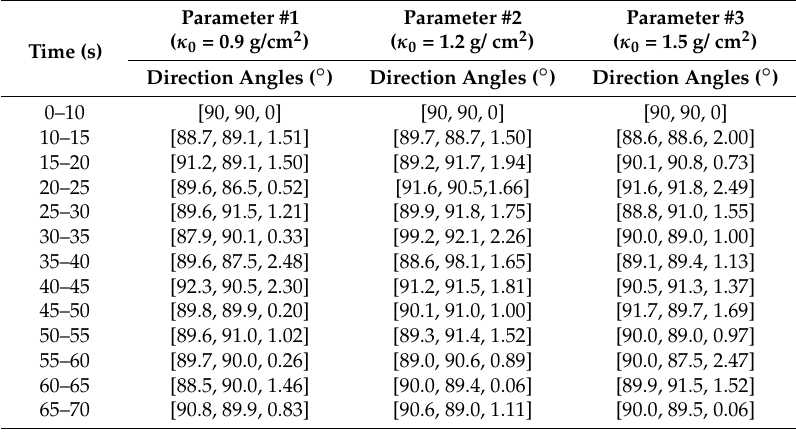
Table 2. Variations of the vibration direction in DEM simulations.